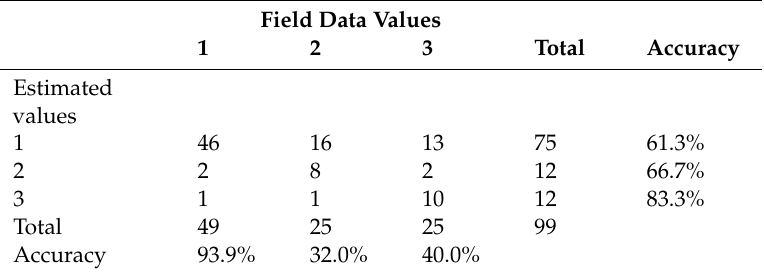
Table 4. Need for pre-harvest clearing of understory trees in three classes based on the e-questionnaire survey mean field data values versus the values estimated from the ALS model 1 and field data-based LDA